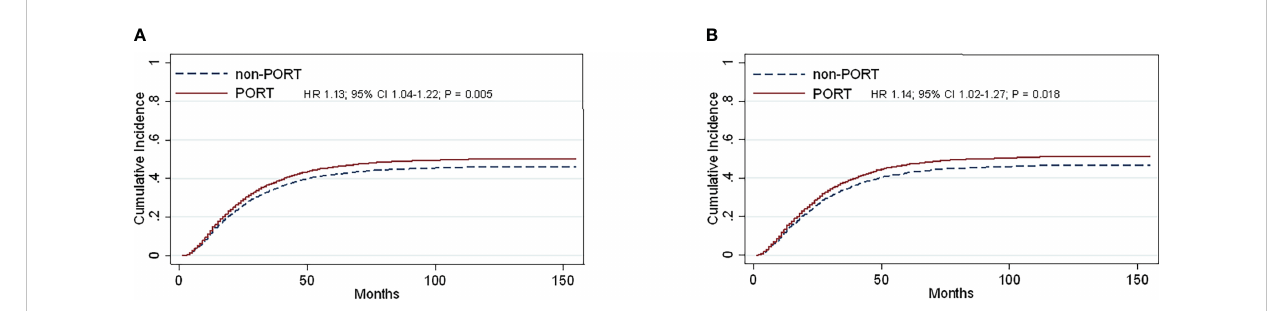
FIGURE 4 Cumulative incidence estimates of stage IIIA-N2 NSCLC patients by PORT ( vs non-PORT) after PSM in death from the lungs (A) and (PORT. vs non- PORT) in death from the lungs in right laterality (B)